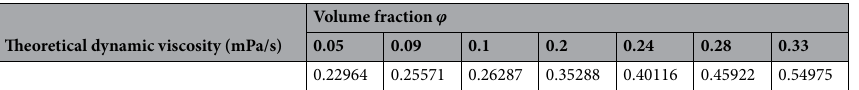
Theoretical dynamic viscosity (mPa/s)